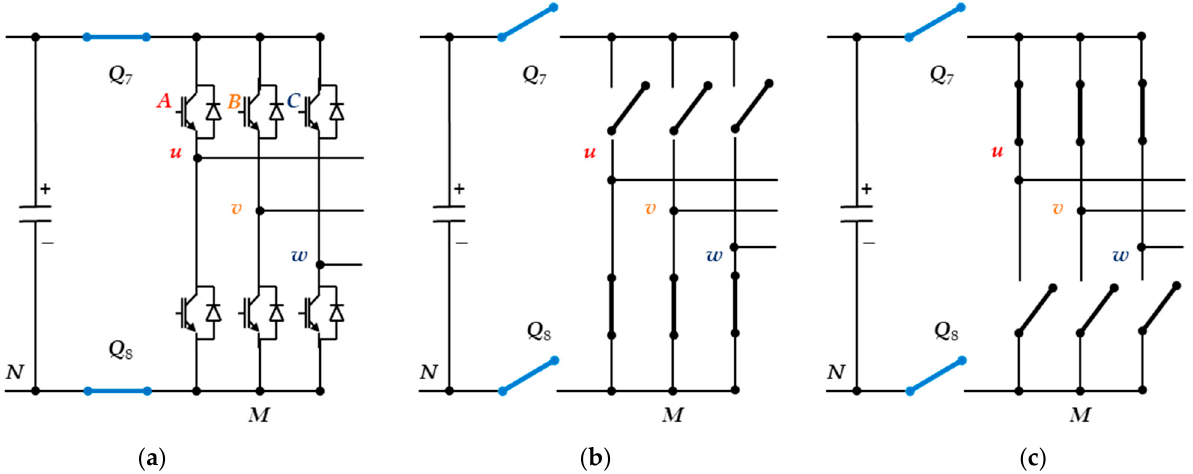
Figure 2. The configurations of the H8 inverter for ( a ) the active states and ( b , c ) the zero states.